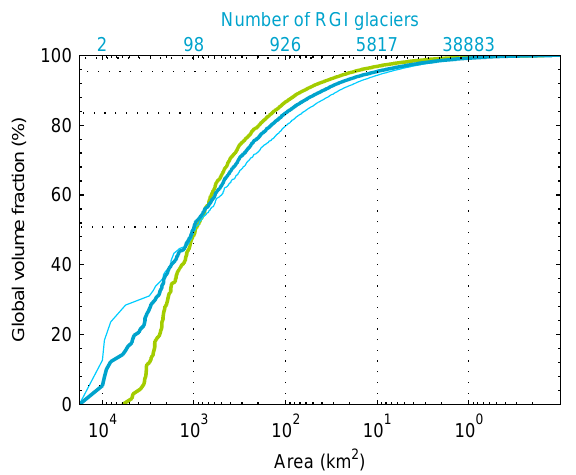
Fig. 4. The volume fraction stored in all the glaciers larger than a given area. Dark cyan shows the results of this study, and thin bright cyan excluding regions with many glacier complexes in RGI v2 (see Table 6). The distribution from Huss and Farinotti (2012) is shown in